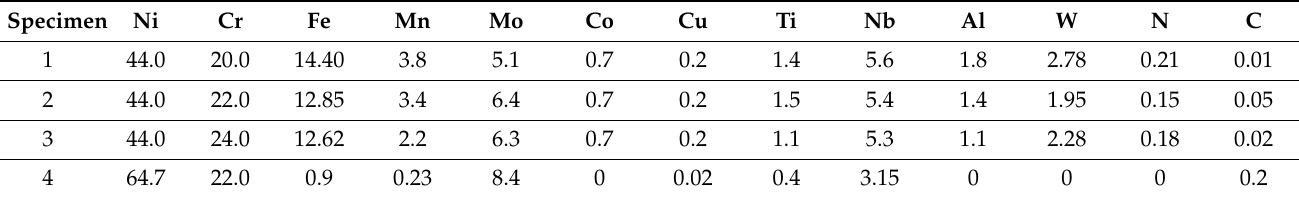
Table 1. Chemical composition of flux-cored wire (wt%).